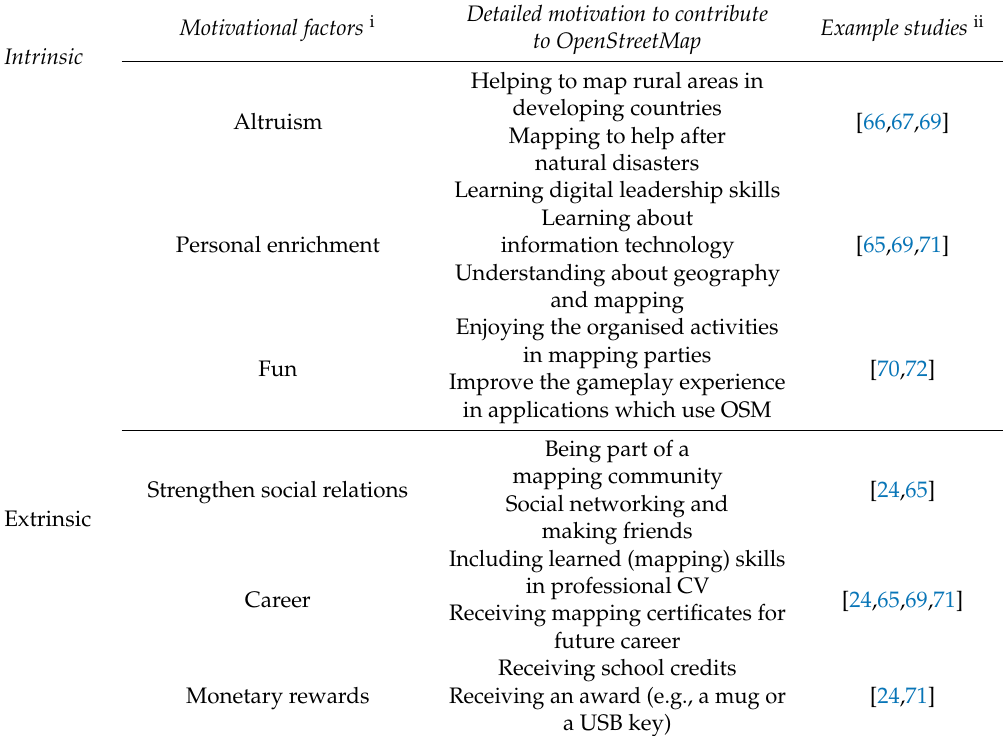
Table 1. Some of the motivational factors to contribute to